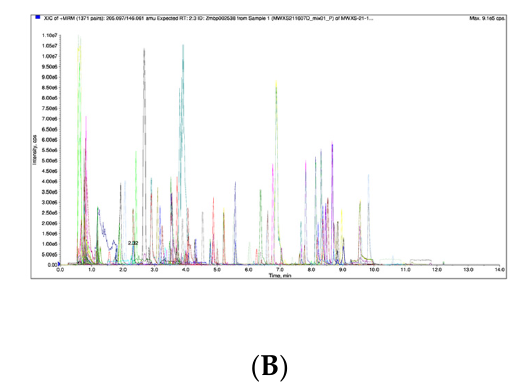
Figure 3. Multi-peak figure for MRM metabolite detection (each different colored mass spectrum peak represents one metabolite detected). ( A ) Negative ion mode. ( B ) Positive ion mode.